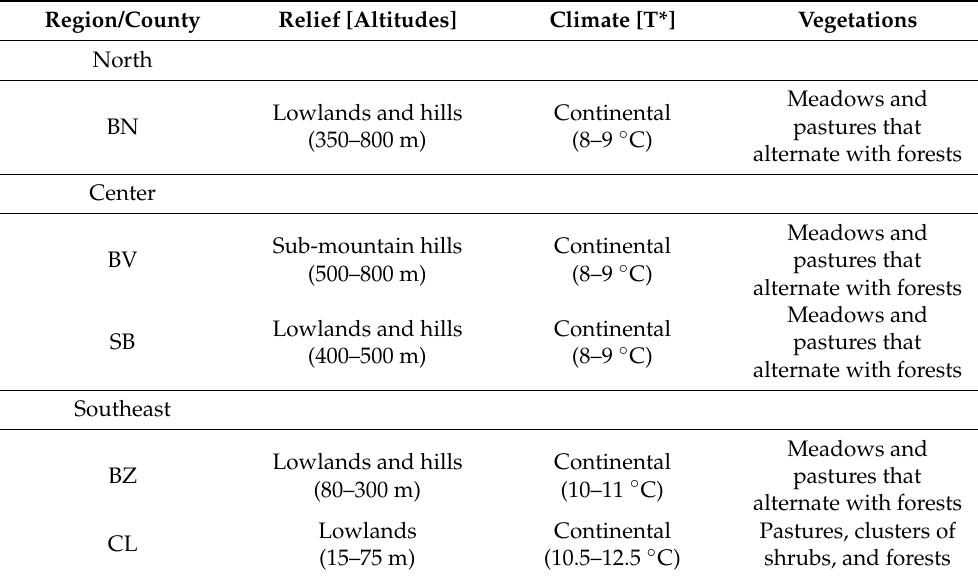
Table 1. Geographic characterization of the horses’ originating